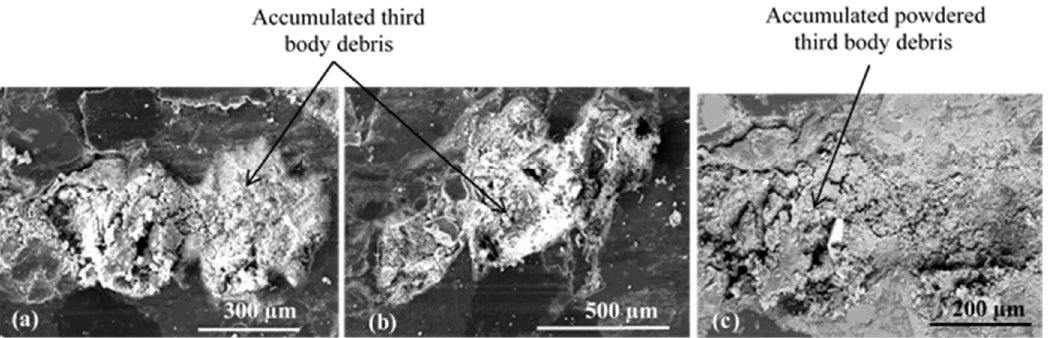
Figure 16. Tribological behaviour of fibre balls located at open contact zone at IR (SEM, ( a , b ) SE and ( c ) BSE).